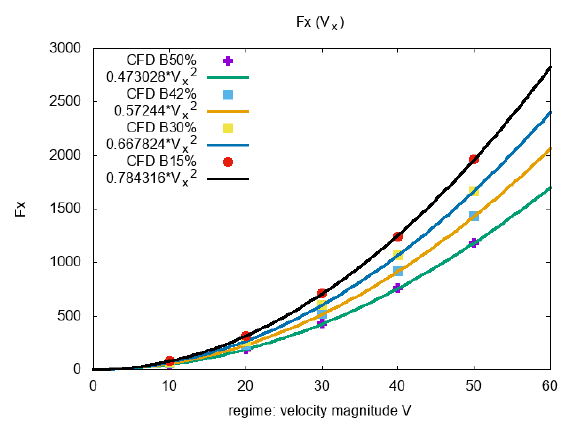
Fig. 1. CFD simulations, force F x acting on the barrier de- pending on the regime velocity u ∞ , barriers 50%,42%,30%,15% (from top left), the computed values are fitted with the quadratic curves.